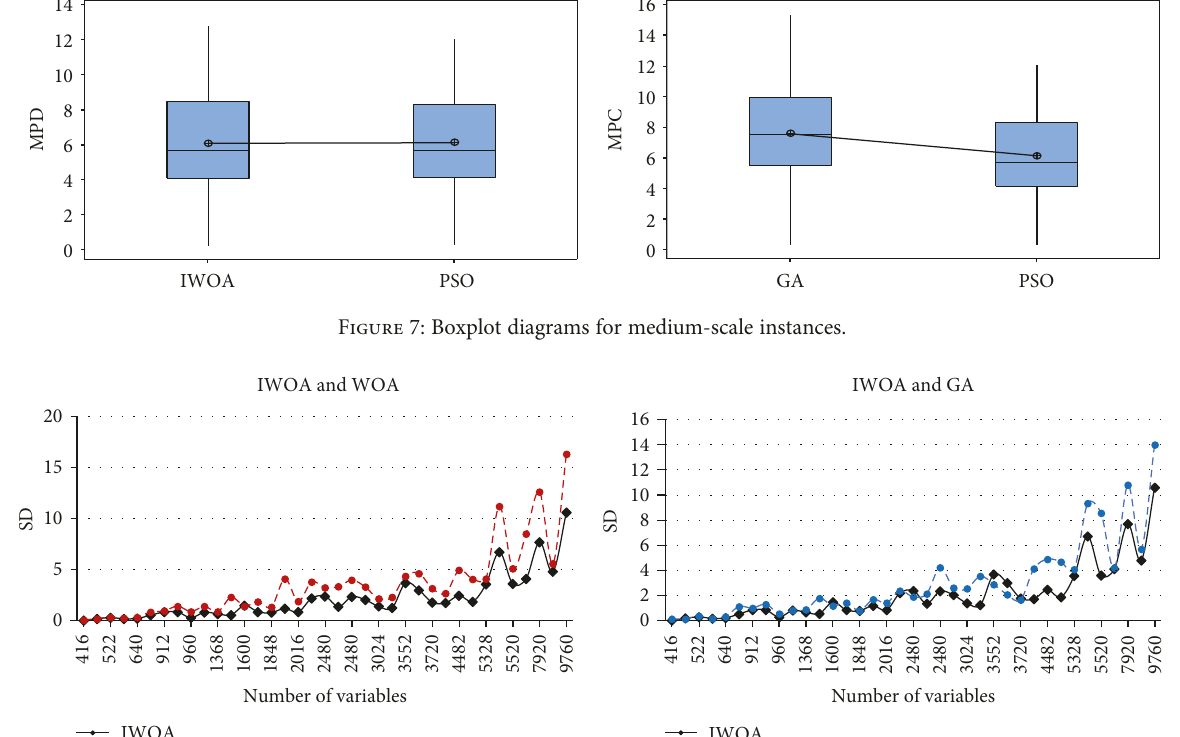
Figure 8: SD comparison of IWOA with WOA and GA for medium-scale